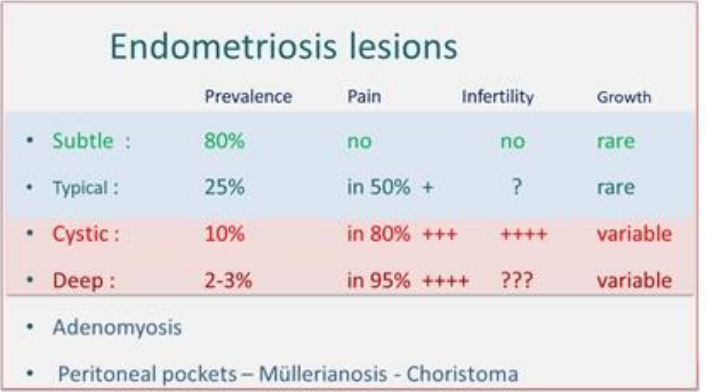
Figure 5. Endometriotic lesions as a cause of pain and infertility. Adenomyosis, peritoneal pockets and Müllerianosis are not discussed. and Müllerianosis are not